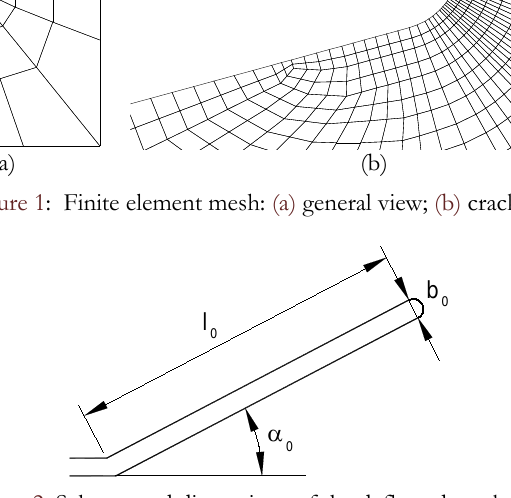
Figure 2: Scheme and dimensions of the deflected crack